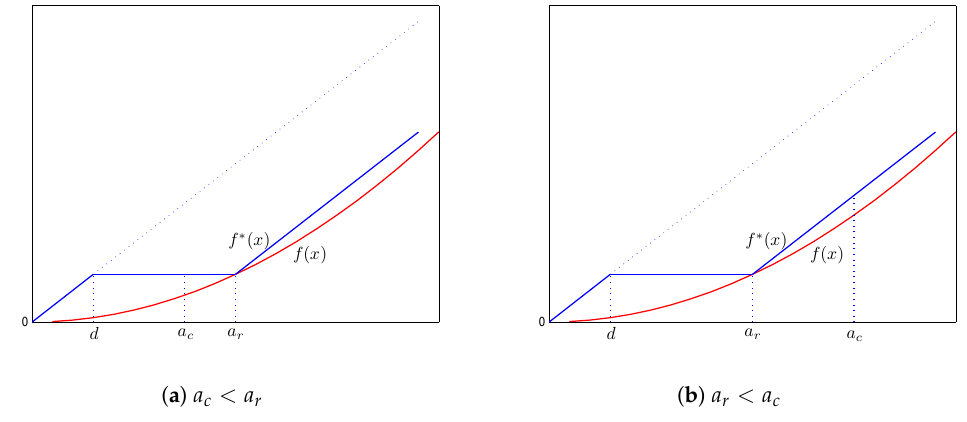
Figure 4. Optimal ceded functions in C 1 : Case